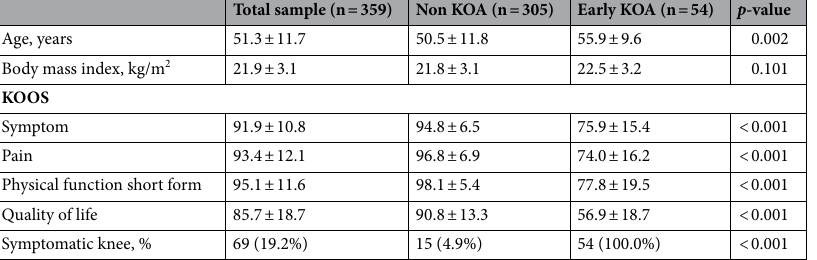
the tibia and femur are divided into three subregions (anterior, central, and posterior), and the tibia has one additional subregion, representing the area beneath the tibial spine. The patella is divided into medial and lat- eral subregions. Cartilage damage was scored in each of the 14 articular surfaces (excluding region S) from 0 (normal thickness and signal) to 6 (diffuse [≥ 75% of the region] full-thickness loss). BMLs were each scored as integers from 0 to 3, where 0 = normal; 1 = mild, < 25% of the region; 2 = moderate, 25–50% of the region; and 3 = severe, > 50% of the region. Subchondral cysts were graded in each region from 0 to 3 based on the extent of regional involvement, as for BMLs. Bone attrition was defined as flattening or depression of the articular sur- faces and was graded from 0 to 3 based on the subjective degree of deviation from the normal contour: 0 = nor- mal, 1 = mild, 2 = moderate, and 3 = severe. Osteophytes along 14 different margins of the knee, the anterior, central weight-bearing, and posterior margins of the femoral condyles and tibial plateaus, and the medial and lateral margins of the patella were graded from 0 to 7 using the following scale: 0 = none; 1 = equivocal; 2 = small; 3 = small-moderate; 4 = moderate; 5 = moderate-large; 6 = large; and 7 = very large. Meniscal lesions were graded separately from 0 to 4: 0 = intact; 1 = minor radial tear or parrot-beak tear; 2 = non-displaced tear or prior surgi- cal repair; 3 = displaced tear or partial resection; and 4 = complete maceration/destruction or complete resection. Since joint effusion and synovial thickening cannot be distinguished from each other, synovitis was graded col- lectively from 0 to 3 in terms of the estimated maximal distention of the synovial cavity: 0 = normal; 1 = less than 33% of maximum potential distention; 2 = 33–66% of maximum potential distention; and 3 = more than 66% of maximum potential distention. For cartilage damage, BMLs, subchondral cysts, bone attrition, and osteophytes, we computed the number of subregions with damage as the number of subregions with a score of > 0. For menis- cal lesions, we computed the maximum meniscal damage grade for the entire knee. The intra-rater and inter- rater reliabilities, expressed as ICC (1,1) and (2,1) of scoring MRI, were 0.929 and 0.921, respectively. Statistical analysis. The mean values of continuous variables (age, BMI, and KOOS) were compared using the Mann ‒ Whitney U test. The chi-square test was used to compare the prevalence of MRI lesions between the non-KOA and early KOA groups. To evaluate the relationship between knee symptoms and MRI lesions, we per- formed crude and adjusted logistic regression analyses, with the presence of knee symptoms as an independent variable, and age, BMI, and the total score of each MRI lesion as dependent variables. Furthermore, to evaluate the relationship between knee pain and MRI lesions, we performed multiple logistic regression analyses with the presence of knee pain as an independent variable, and age, BMI, and each MRI lesion as dependent variables. Data analysis was conducted using SPSS (version 24.0; IBM Corp., Armonk, NY, USA) in a cross-sectional man- ner. Statistical significance was set at P < 0.05.